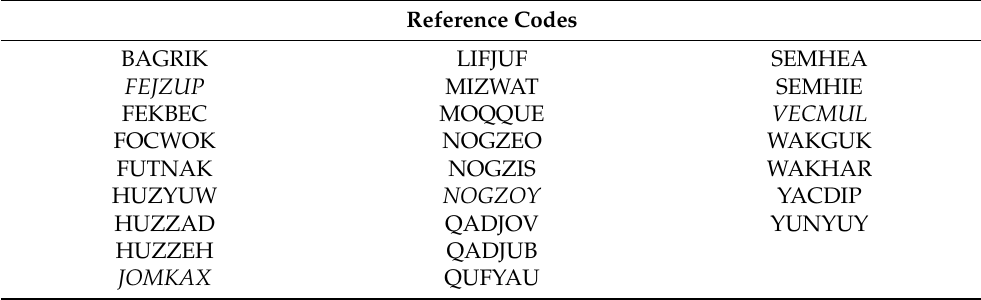
Table 1. CSD reference codes of the nitrido-osmium(VI) derivatives present in the database. Those exhibiting osme bonds are shown in italics.